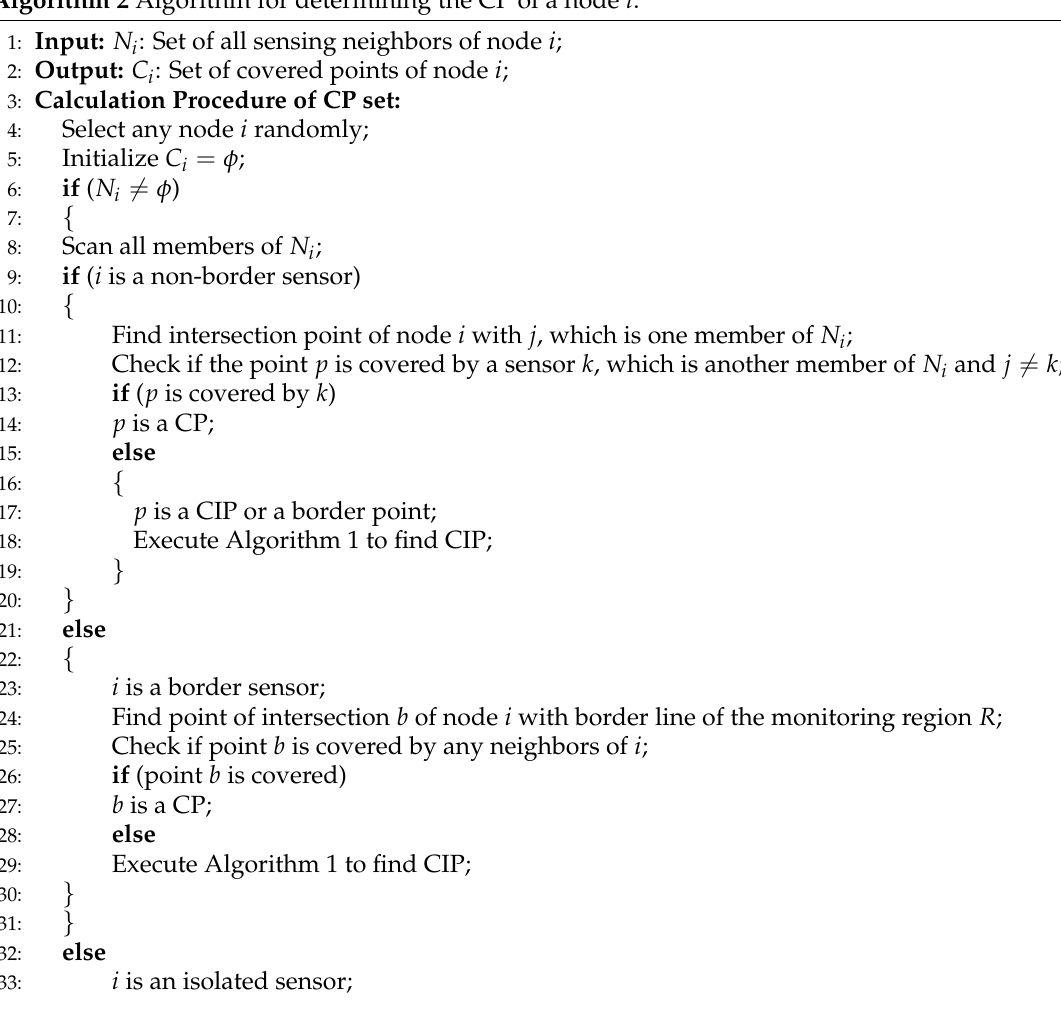
Algorithm 2 Algorithm for determining the CP of a node i